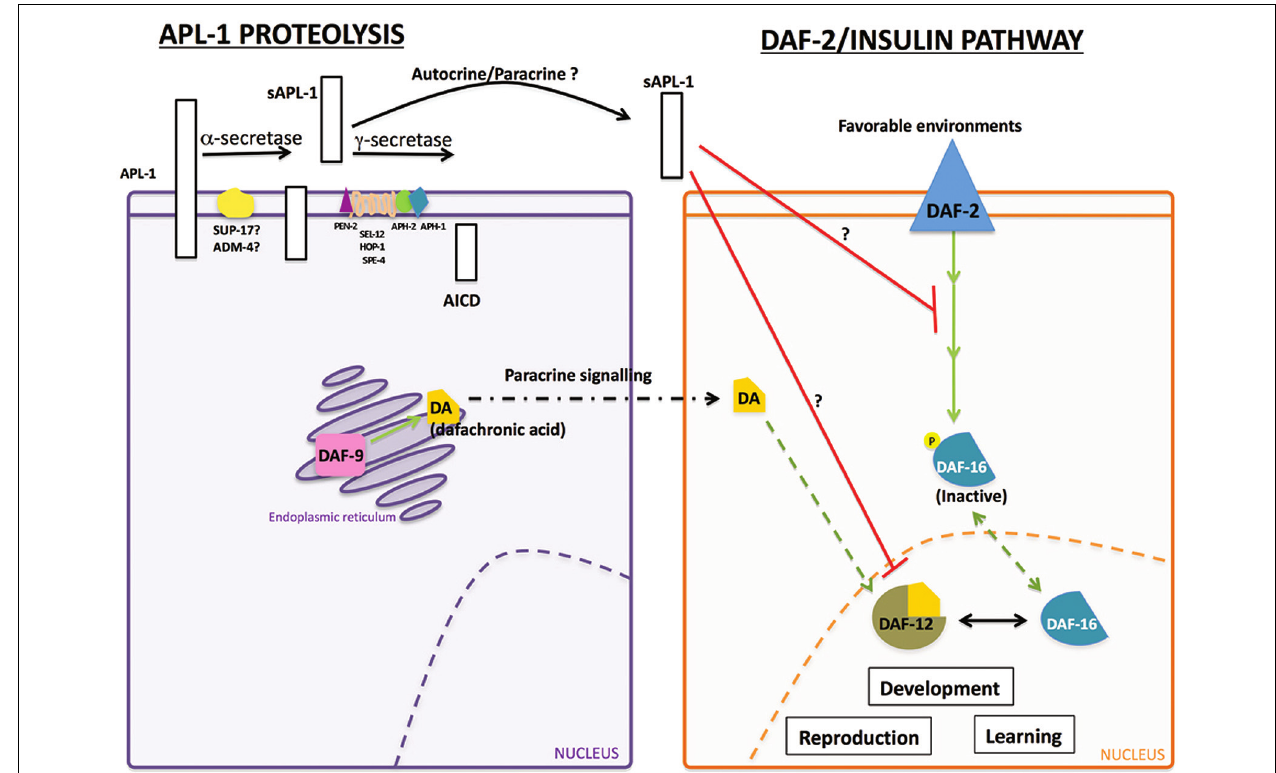
FIGURE 2 | Interaction between sAPL-1 and DAF-2 insulin/IGF-1 receptor and DAF-12/NHR pathways. Schematic representation of APL-1 proteolytic pathway and how sAPL-1 may modulate DAF-2 insulin/IGF-1 receptor and DAF-12/NHR signaling pathways. APL-1 is cleaved by the α / γ -secretase pathway in C. elegans . Released sAPL-1 could act as a signaling molecule in